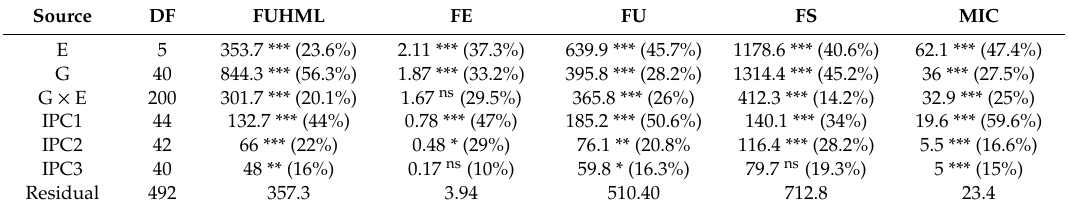
Table 4. Analysis of variance and partitioning of the G × E interaction by the AMMI model for fiber quality